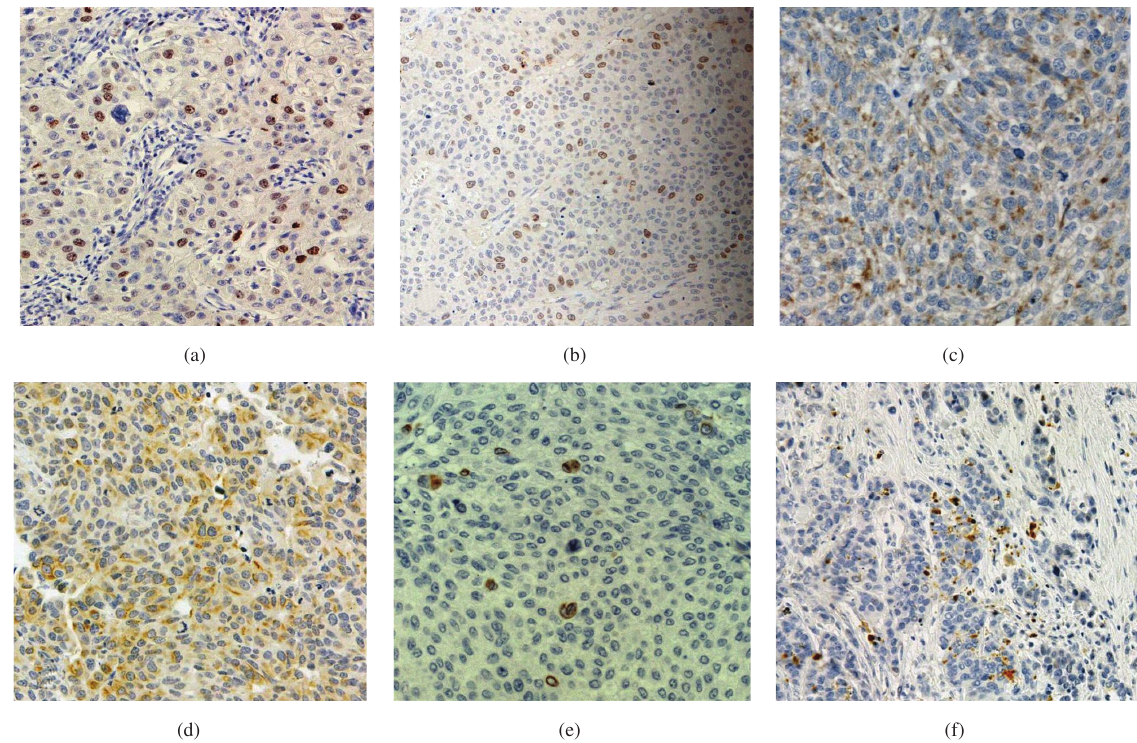
FIGURE 1: The representative immunohistochemical staining of apoptotic markers in BEN-associated urothelial carcinoma, with strong nuclear Survivin activity in high grade (a) and tumors with solid growth (b), diffuse Bax cytoplasm expression (c), membranous Fas staining in nonmetaplastic BEN-related tumors (d). Rarely Bcl-2 positive tumor cells (e). Caspase 3 expression in a high-grade tumor (f) (original magnification: